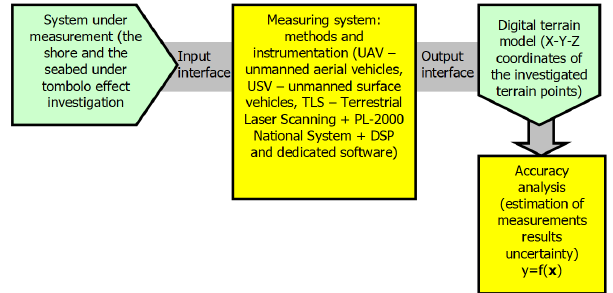
Figure 3. Geodetic and hydrographic measurements of the X-Y-Z coordinates of the investigated terrain points, designations concerning the function y = f(x) are explained in the text.